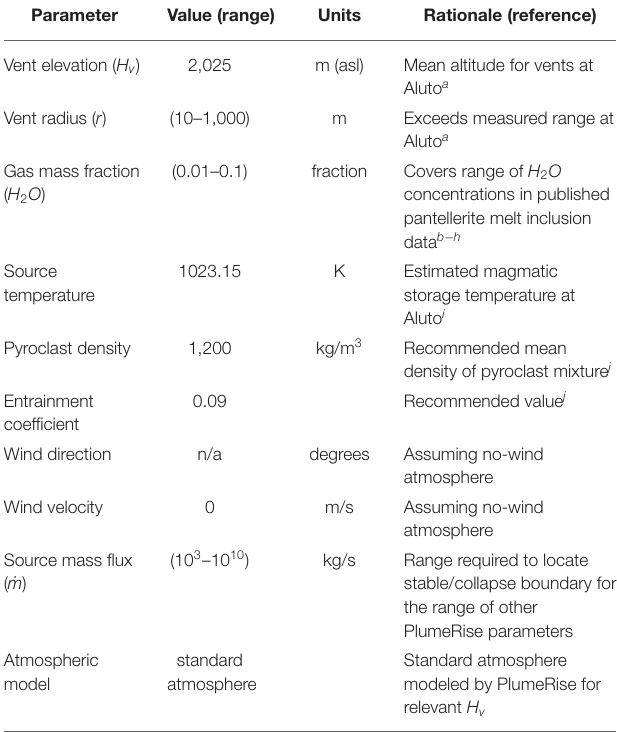
TABLE 1 | Parameters used in the PlumeRise model to locate the stable/collapsing column boundary in mass eruption rate/vent radius/gas mass fraction parameter